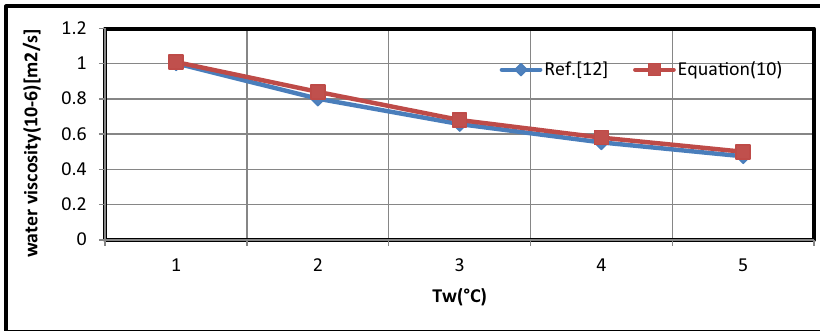
Figure 11: Viscosity of water vs temperature.